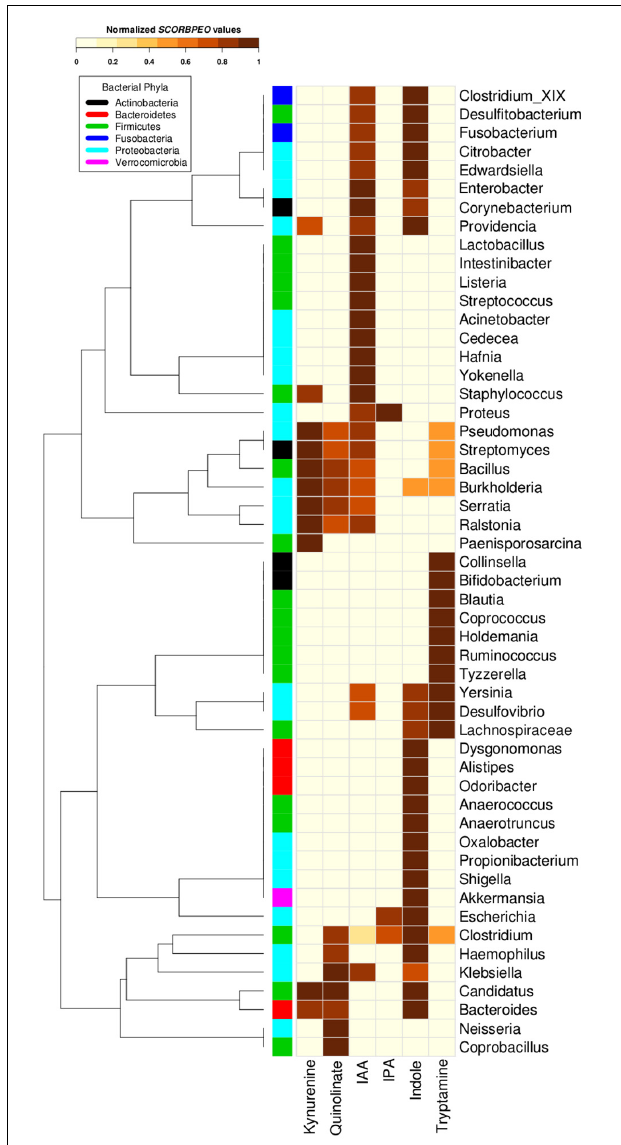
FIGURE 4 | Tryptophan metabolism pathways for neuro-active compound production in bacterial genera found in gut. Distribution of six neuro-active compound production pathways across genera comprising of completely sequenced bacterial genomes found in human gut. Each cell represents “SCORBPEO” (Score for Bacterial Production of Neuro-active Compounds) value corresponding to the pathways in these genera. “SCORBPEO” indicates the relative capabilities for production of a particular neuro-active compound of any genus, evaluated based on the number of pathway containing strains, the database size of the respective genus, and enrichment of the pathway in gut-associated strains of the